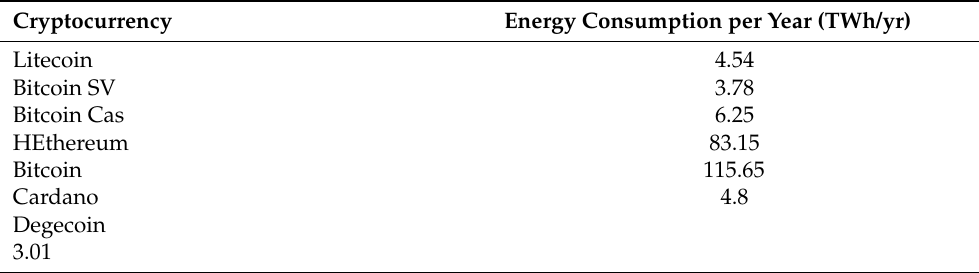
Table 6. Annualized total energy